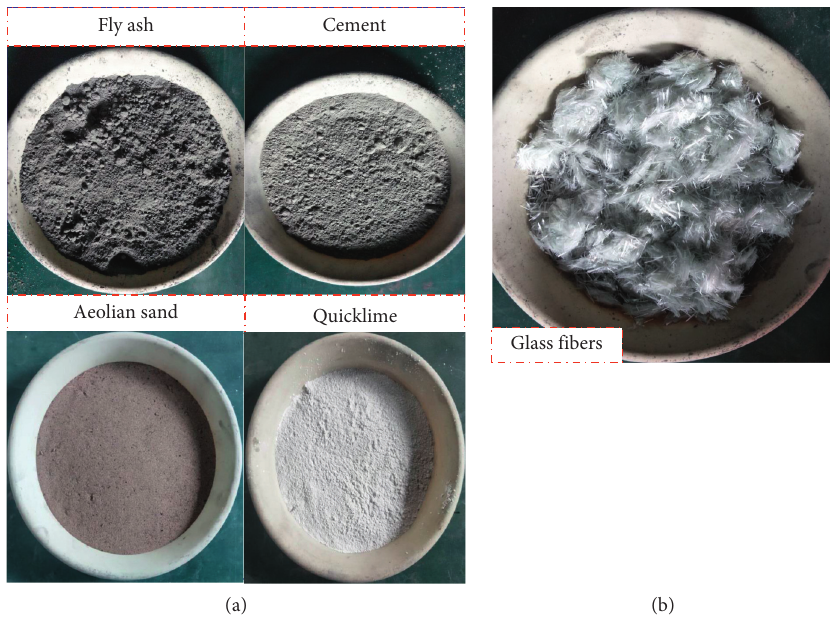
Figure 1: Test materials. (a) Raw materials for the SCPB. (b) Glass